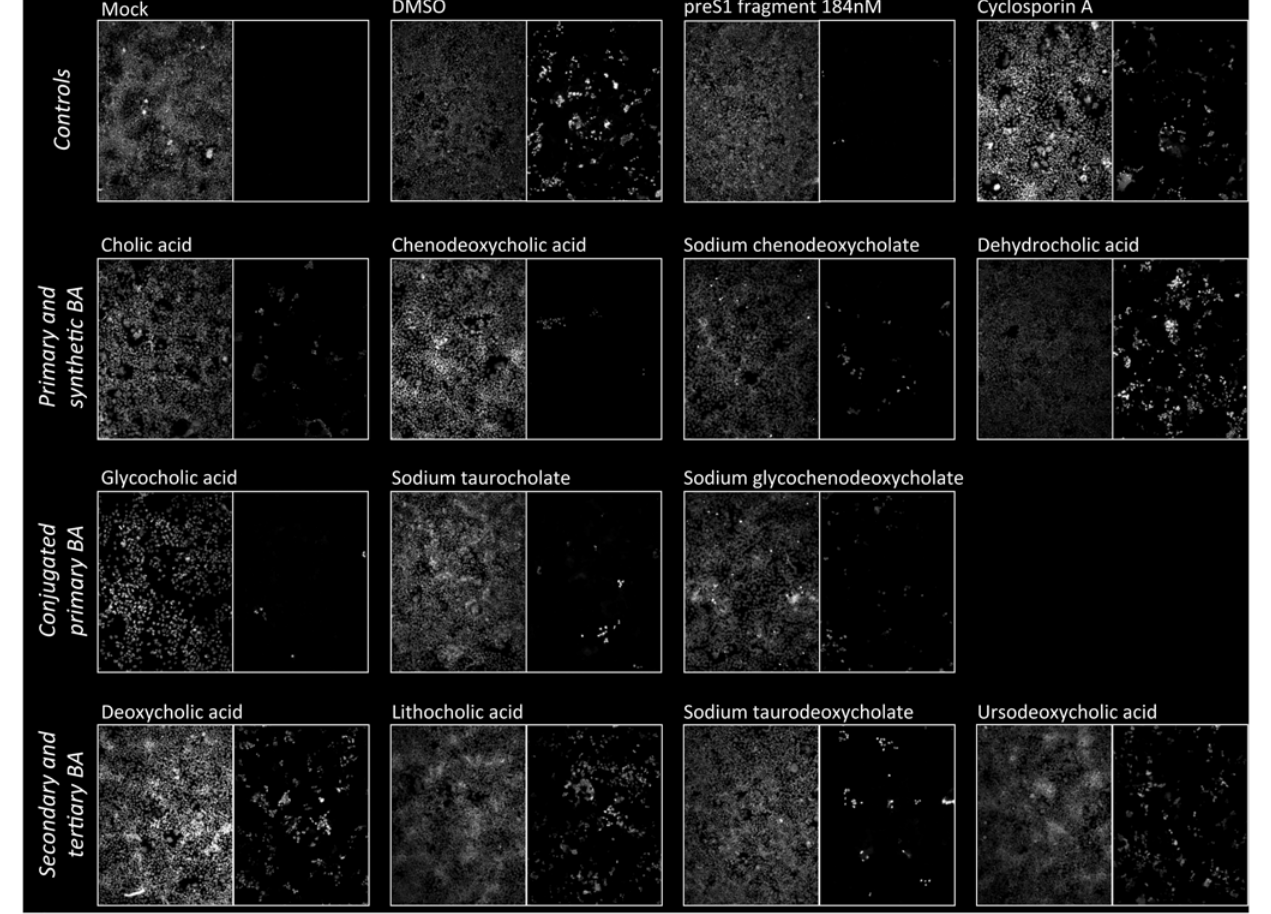
Fig 1. Effect of BA on HDV infection of HuH-7/hNTCP cells. HuH-7/hNTCP cells were exposed to HDV containing supernatant in the presence or absence of 200 µ M of different BA. For glycocholic acid 50 µ M results are shown because the BA is toxic at 200 µ M. preS1 peptide (368 nM) and cyclosporine A (25 µ g/mL) served as positive controls. After 6 h cells were washed and repleted with regular media without virus, BA or drugs. After another 5 d cells were fixed and stained with a polyclonal antibody against HDV antigen (right hand images in each panel). Nuclei were counterstained with DAPI (left hand images). A representative of at least three independent experiments is